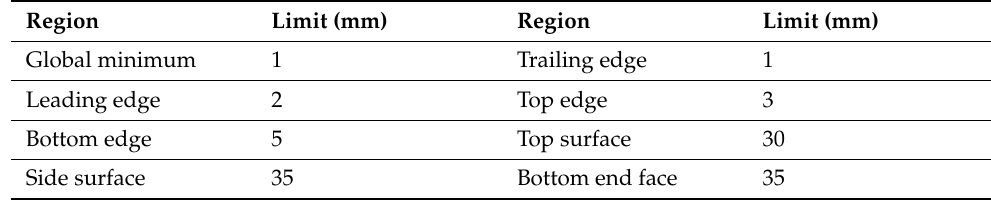
Table 2. Grid size of the vertical tail model.